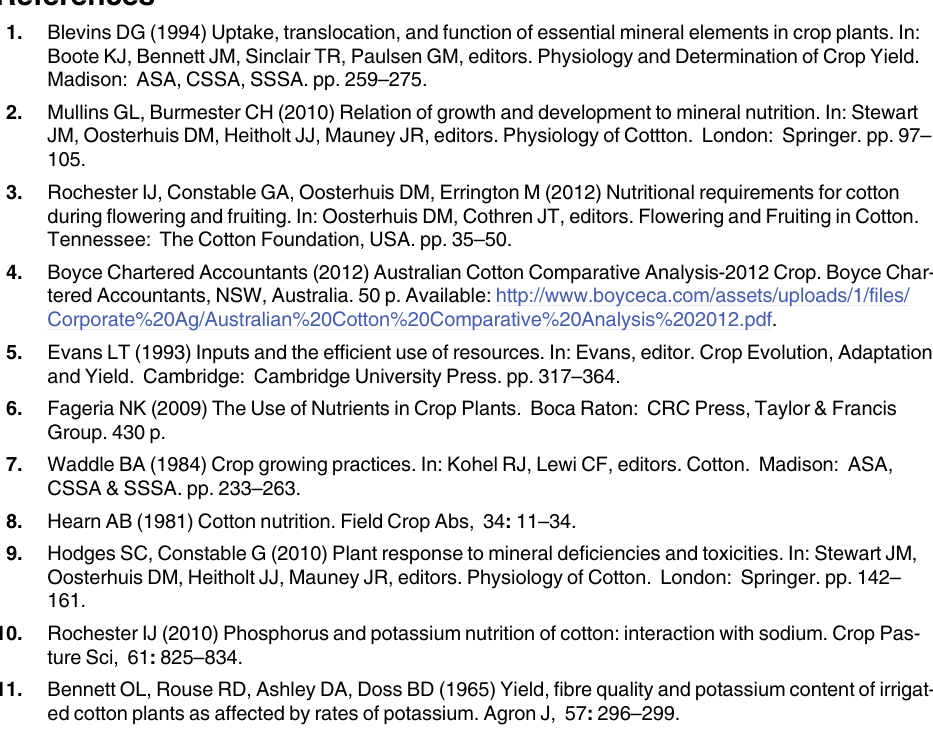
S2 Table. Genes in G . raimondii that are located in the interval spanning the cluster of nu- trient concentration QTLs mapped in the G . hirsutum × G . barbadense RIL population. G . raimondii Chromosome 5 is highly syntenic to the G . hirsutum Chromosome 14 belonging to the Dt sub-genome. Genes potentially involved in ion transport are indicated in red, while the region spanning the most central three markers in the interval are marked in yellow. S3 Table. Pearson correlation coefficients of five macronutrient, Na concentrations and K/ Na ratio in leaves with yield components and fibre properties in the RIL population based on a combined data analysis over two seasons. S4 Table. Pearson correlation coefficients of five micronutrient concentrations in leaves with yield components and fibre properties for the RIL population based on a combined data analysis over two